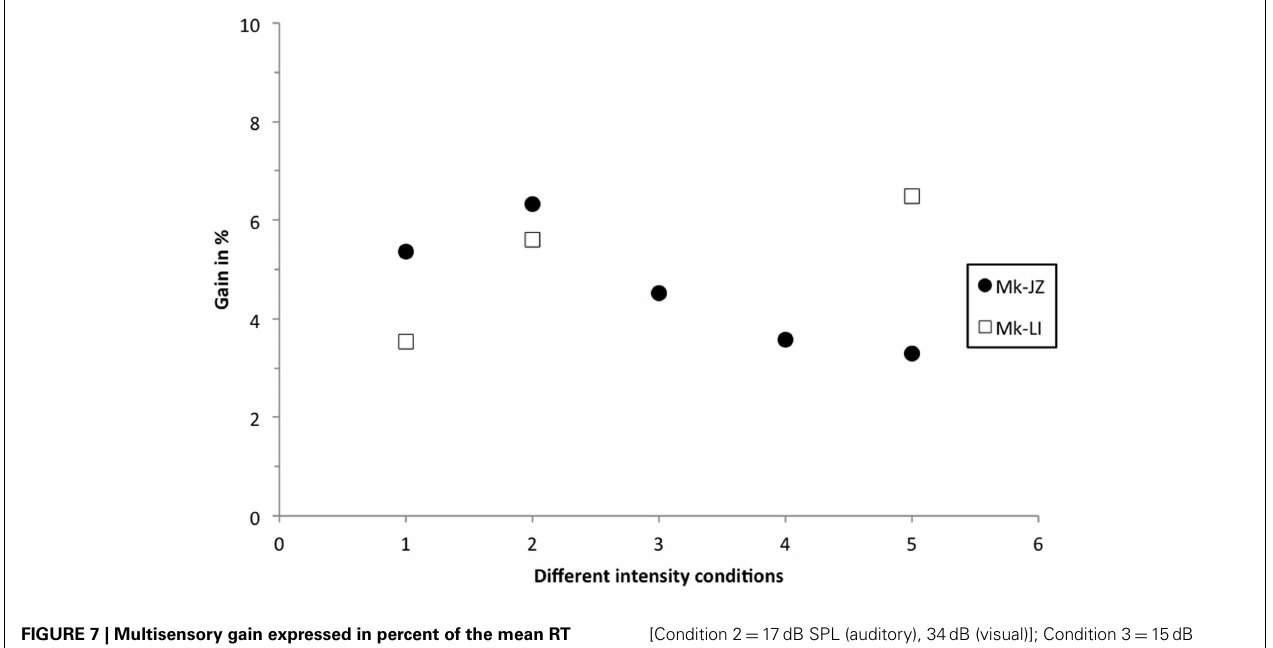
FIGURE 7 | Multisensory gain expressed in percent of the mean RT in visuo-acoustic conditions as compared with the mean RT of the fastest unisensory condition . Filled circles display the values for Mk-JZ as a function of the stimulus conditions shown in Figure 2 [Condition 1 = 17dB SPL (auditory), 34dB (visual)] and Figure 5